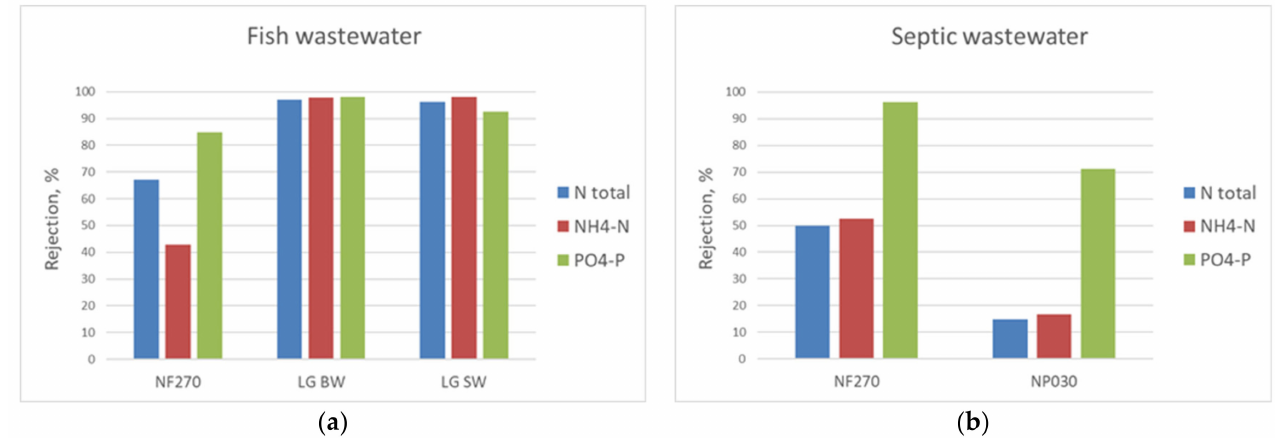
Figure 8. Nutrient rejection of selected NF (NF270, NP030) and RO (LG BW, LG SW) membranes for fish processing wastewater ( a ) and septic wastewater ( b